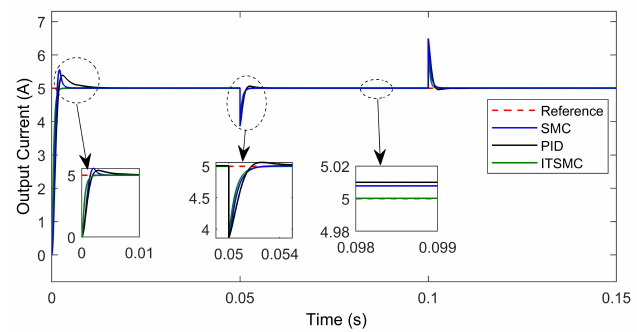
Figure 15. Tracking of I sc , during perturbation in R sc .